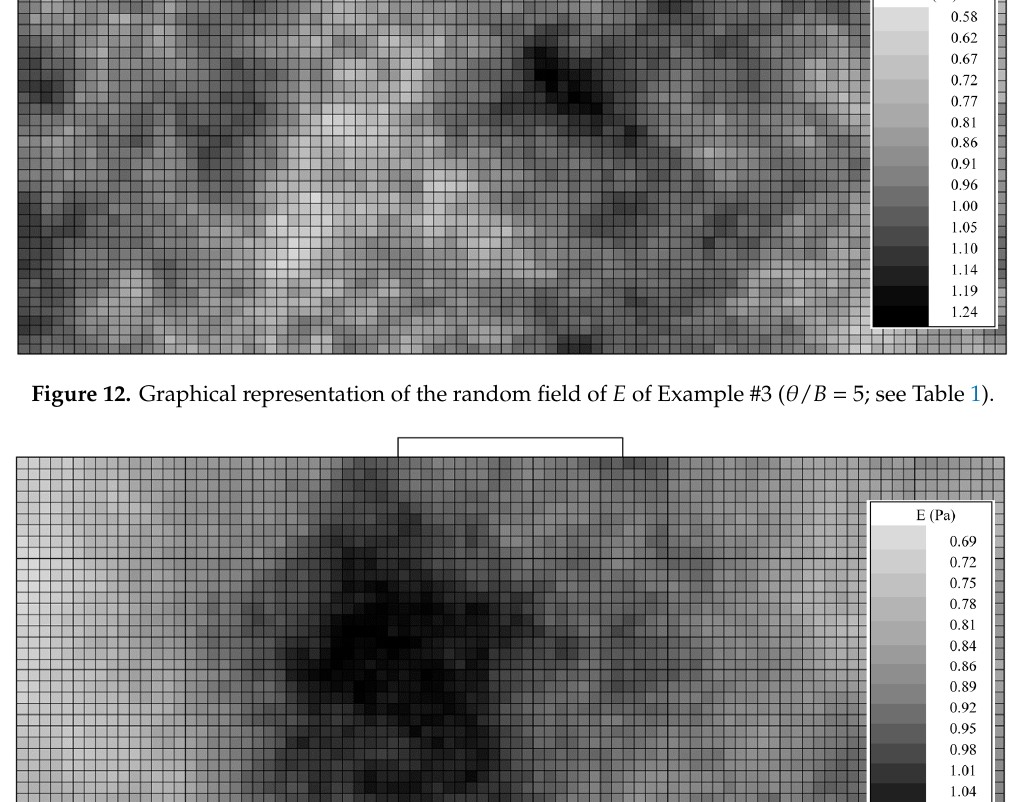
Figure 11. Graphical representation of the random field of E of Example #2 ( B θ = 0.5; see Table 1).